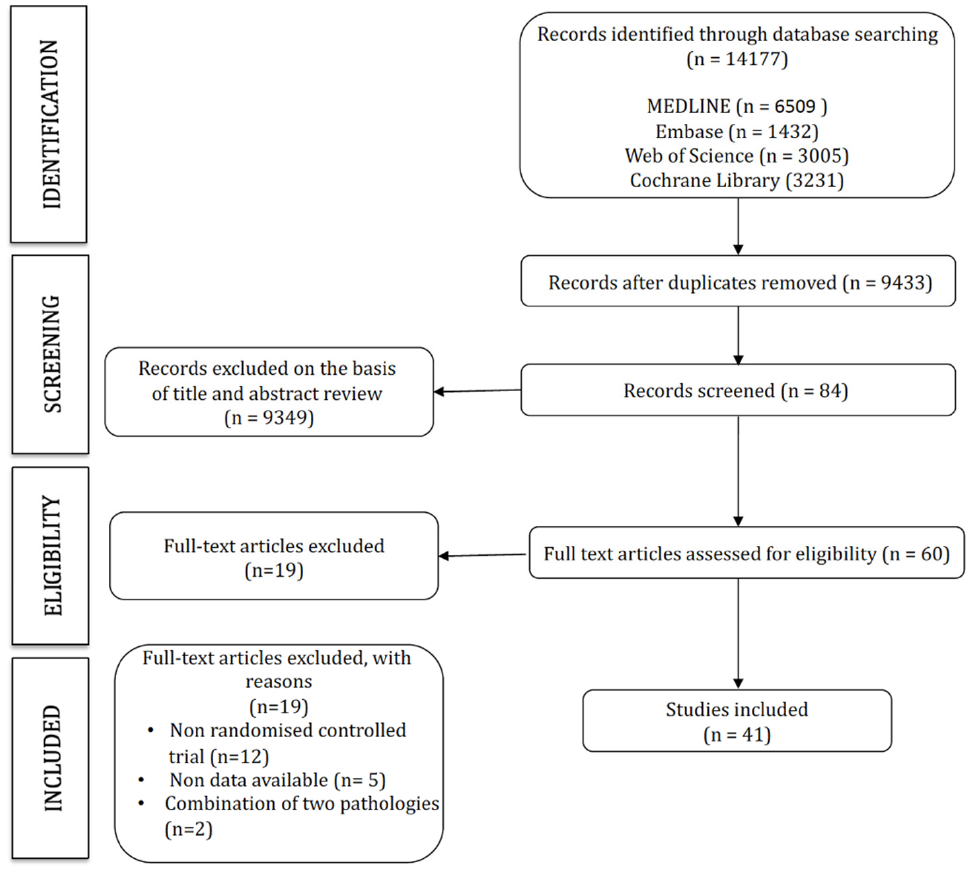
Figure 1. PRISMA flow diagram. Table 1. Characteristics of the population described in the included studies.